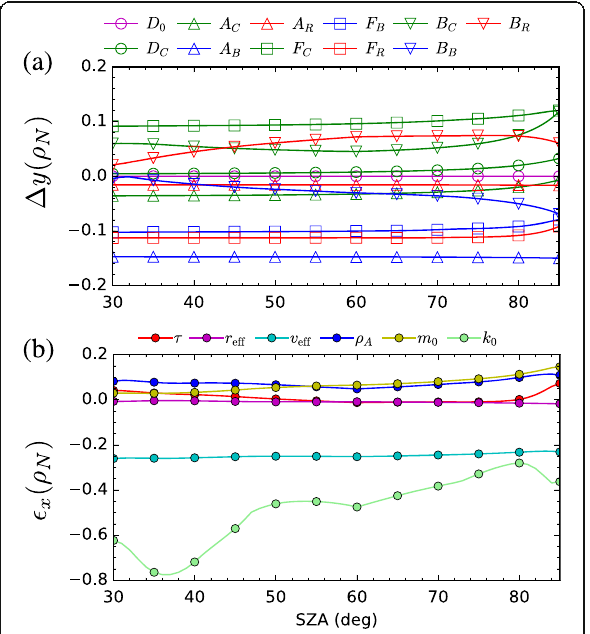
Fig. 10 a Sensitivity of dust observation parameters to the volume mixing ratio of non-spherical dust ( ρ N ). Parameter Δ y represents the difference between the maximum and minimum values of the normalized observational parameters when ρ N is changed from 0 to 1. b Systematic error due to non-spherical dust shape. Systematic errors of normalized dust model parameters are estimated from differences between observational parameters calculated with true (1) and wrong (0) values of the volume mixing ratio of non-spherical dust ( ρ N )